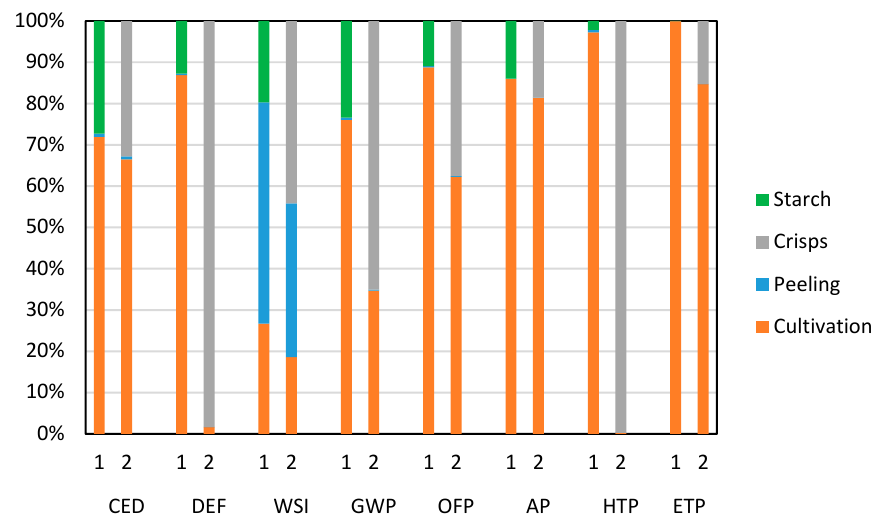
Figure 4. Relative contribution to environmental impacts of the various processing steps in industrial (1) and advanced (2) cassava processing; cumulated energy demand (CED), deforestation (DEF), water stress index (WSI), global warming potential (GWP), ozone formation potential (OFP), acidification potential (AP), human toxicity potential (HTP) and ecotoxicity potential (ETP).